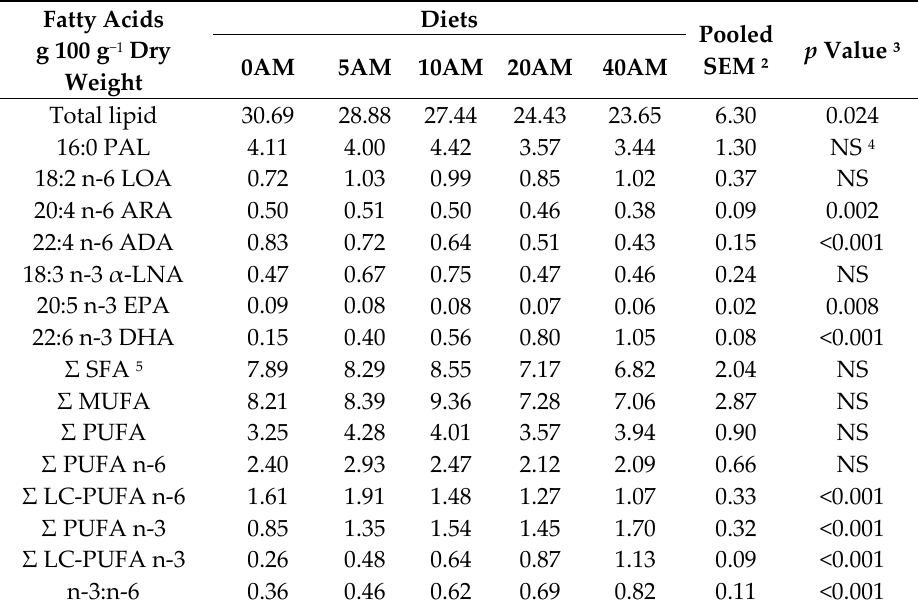
Table 6. Total lipid and fatty acid composition of hepatopancreas in Nile tilapia juveniles fed increasing concentrations of Aurantiochytrium sp. meal (AM) for 87 days, at 22 °C ¹.